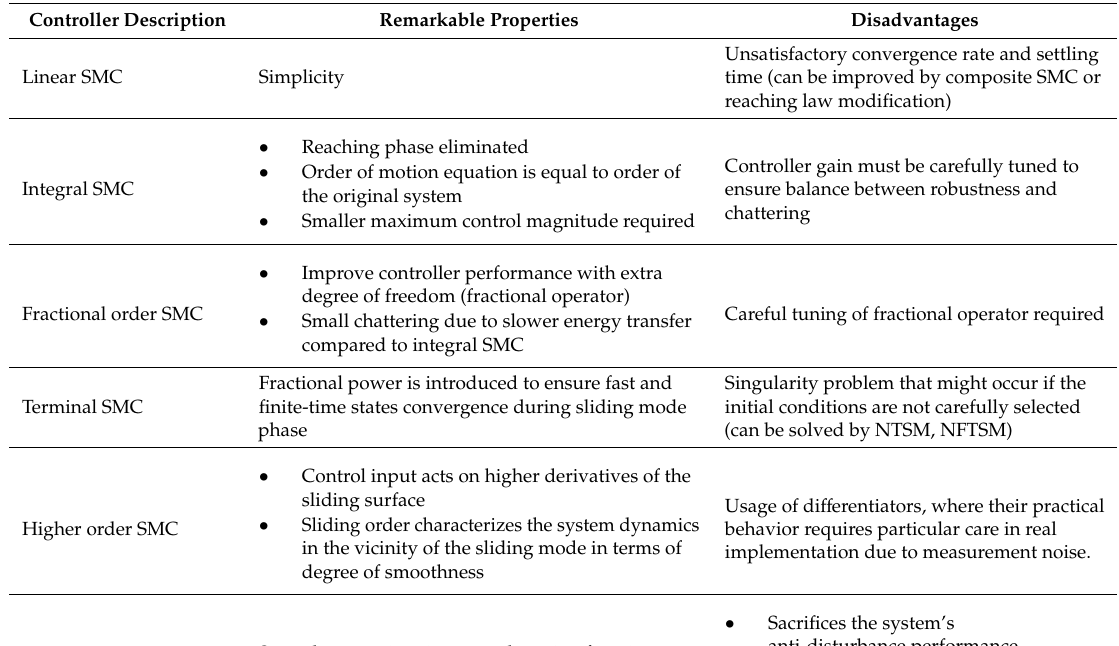
Table 3. Comparison of state-of-the-art implementation of SMC for speed control of